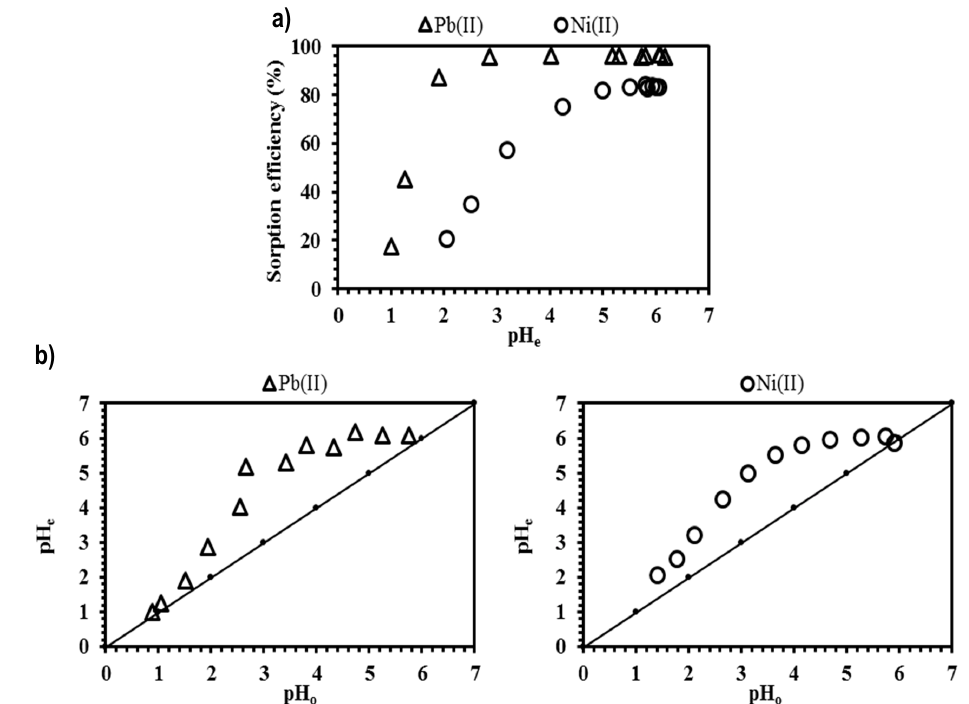
Figure 3. Influence of pH on lead and nickel removal: ( a ) Sorption efficiency; ( b ) Variation in pH using CAM-D2EHPA as sorbent ( T : 20 °C; V : 0.01 L; m : 0.1 g; agitation speed: 180 rpm; contact time: 3 h; C 0 : 50 mg L -1 ; 0.005 M NaNO 3 ) .